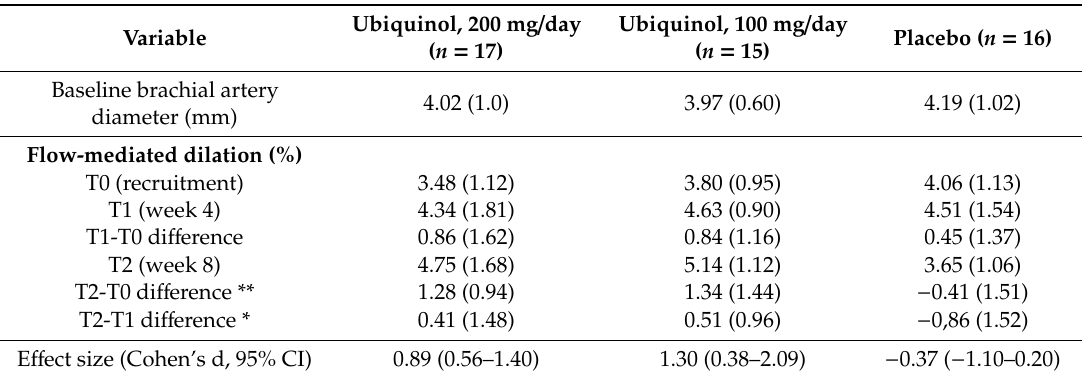
Table 2. Summary of the primary endpoint: Change in flow-mediated dilation (FMD) on week 8, and of the secondary endpoint; Change in FMD on week 4, assessed in the per-protocol population ( n =